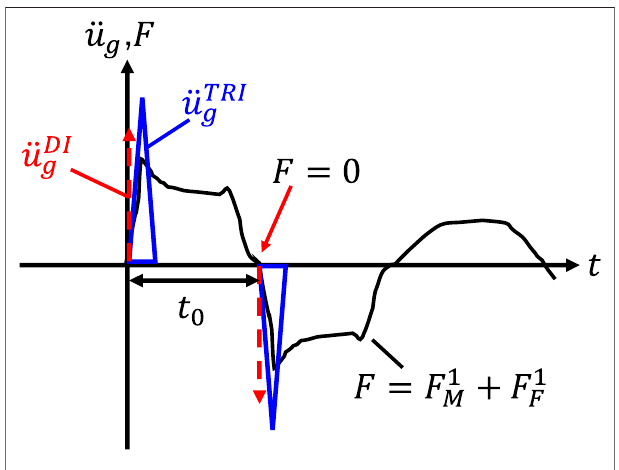
FIGURE 11 | Critical timing of second impulse and simulation of impulse by one-point acceleration input.